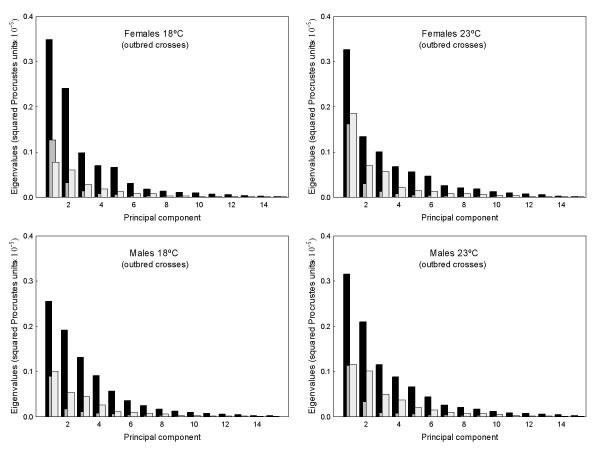
Eigenvalues of causal covariance matrices for wing shape First 15 eigenvalues of the phenotypic (black bars), karyotype (hatched) and crosses (open) covariance matrices from outbred crosses.